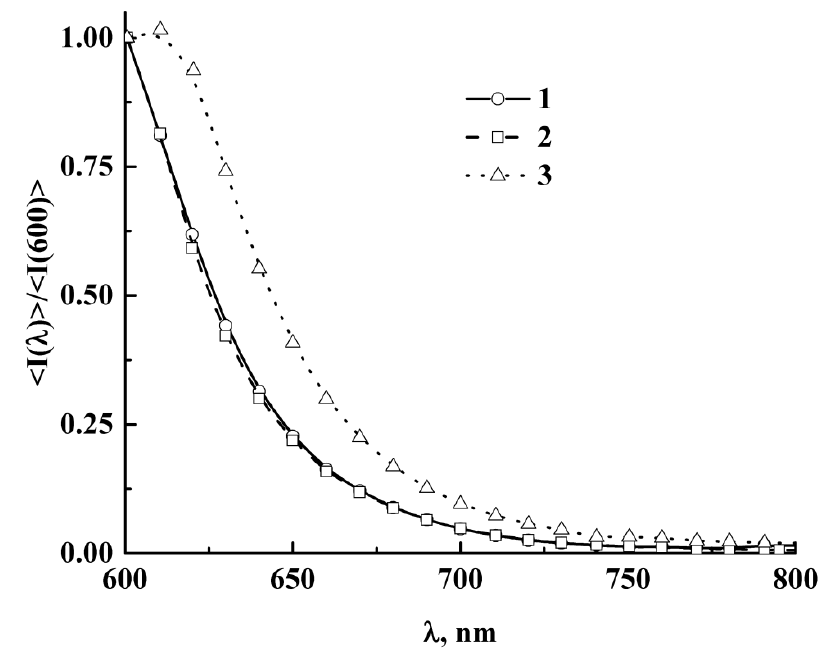
Figure 6. Spectral dependencies of the statistical moments of fluorescence intensity fluctuations obtained in the course of the SiO 2 sample scanning. 1— I ; 2—